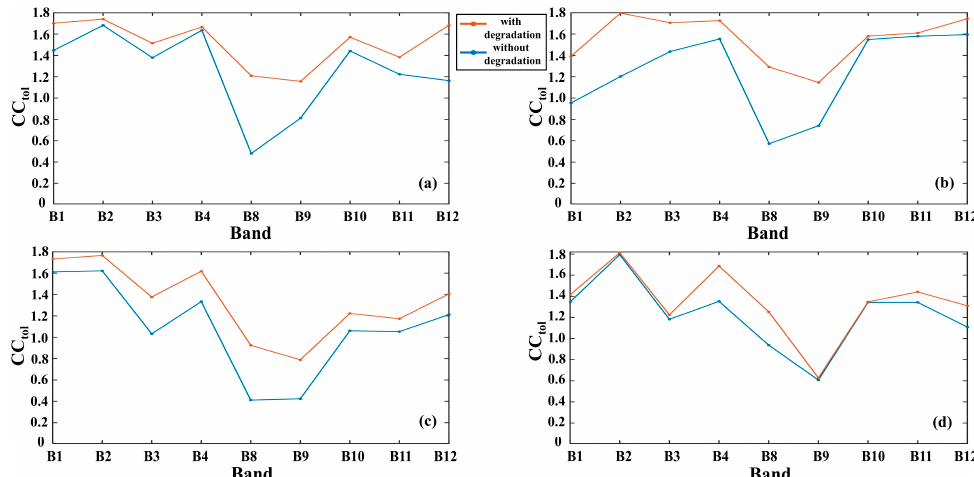
Figure 7. Comparisons of the spatial-spectral correlation coefficient ( (cid:1829)(cid:1829) (cid:3047)(cid:3042)(cid:3039) ) of the fused images with the degradation model (red line) and fused images without the degradation model (blue line) for four dates. ( a ) 2 August 2018; ( b ) 28 December 2019; ( c ) 25 June 2020; ( d ) 2 November 2020.